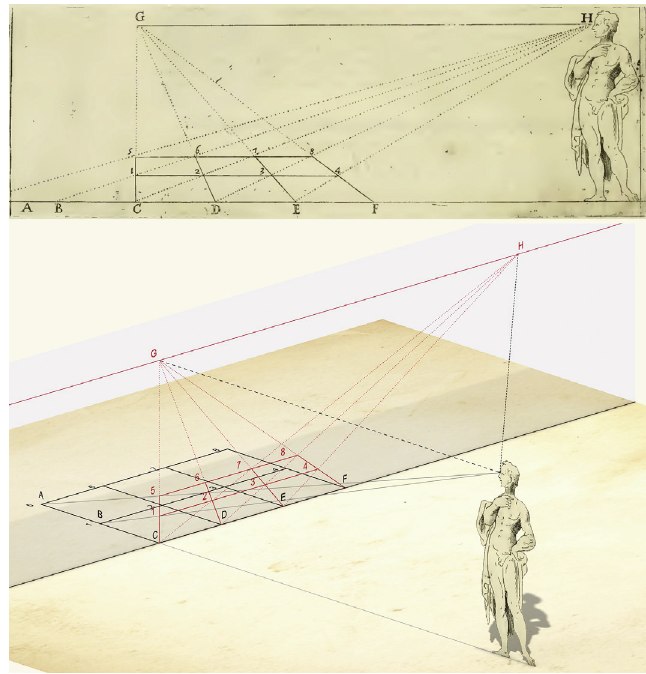
Figure 5 Illustration of the ‘second rule’ by Jacopo Barozzi da Vignola. Author’s